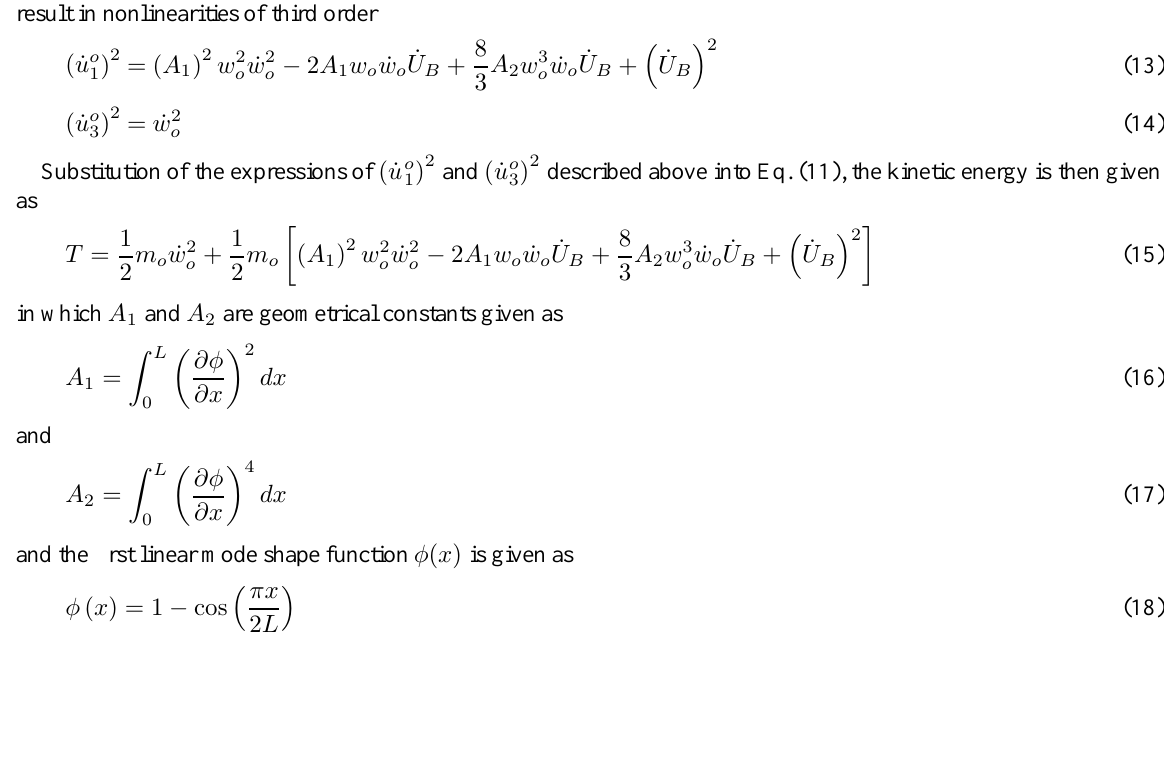
2 2 and ( ˙ u o 3 ) are found and truncated